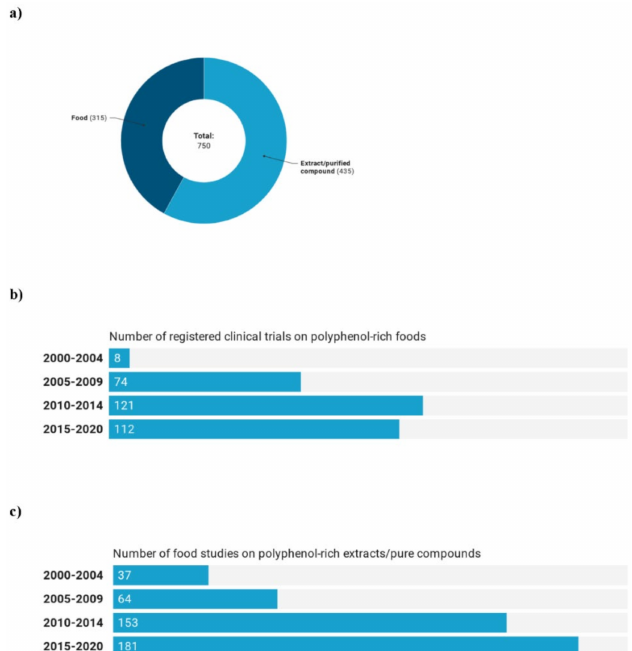
Figure 2. Number ( a ) and trend of registered trials on polyphenol-rich foods ( b ) and extracts or pure compounds ( c ).